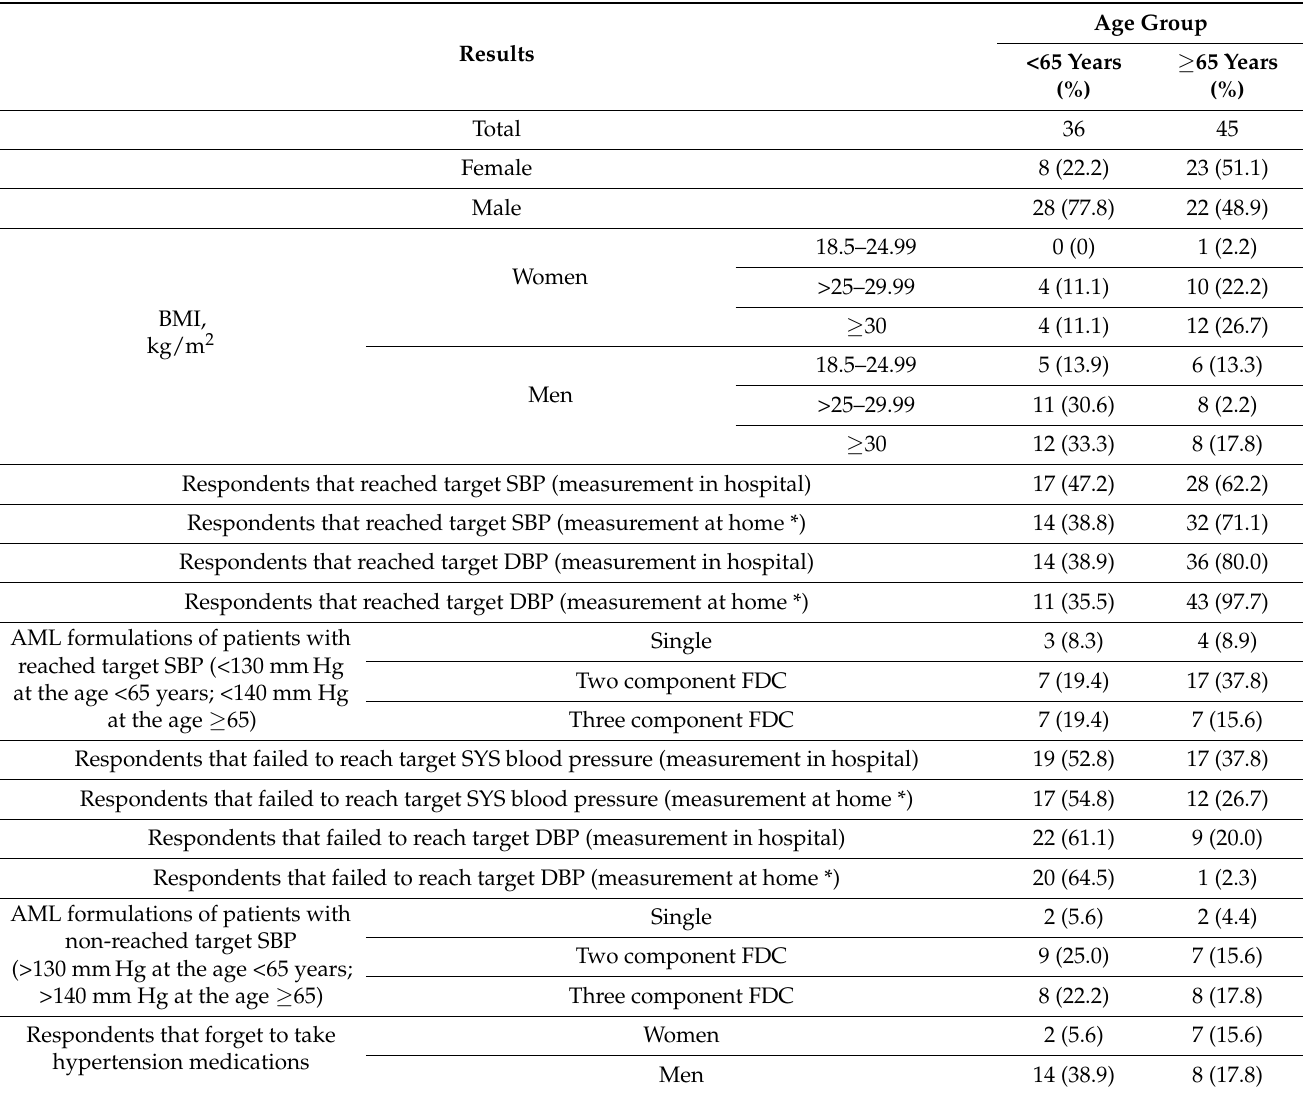
Table 2. Systolic (SBP), Diastolic (DBP) blood pressure at home and in hospital, body mass index (BMI) and medication use habits according to the age